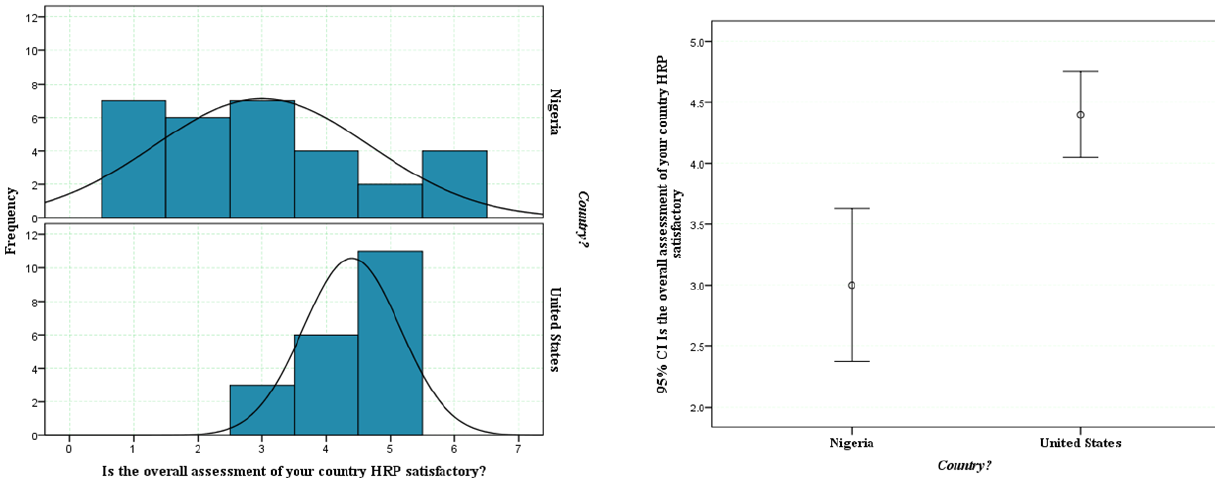
Figure 11. Satisfaction of the overall assessment of country’s HRP (Nigeria and the United